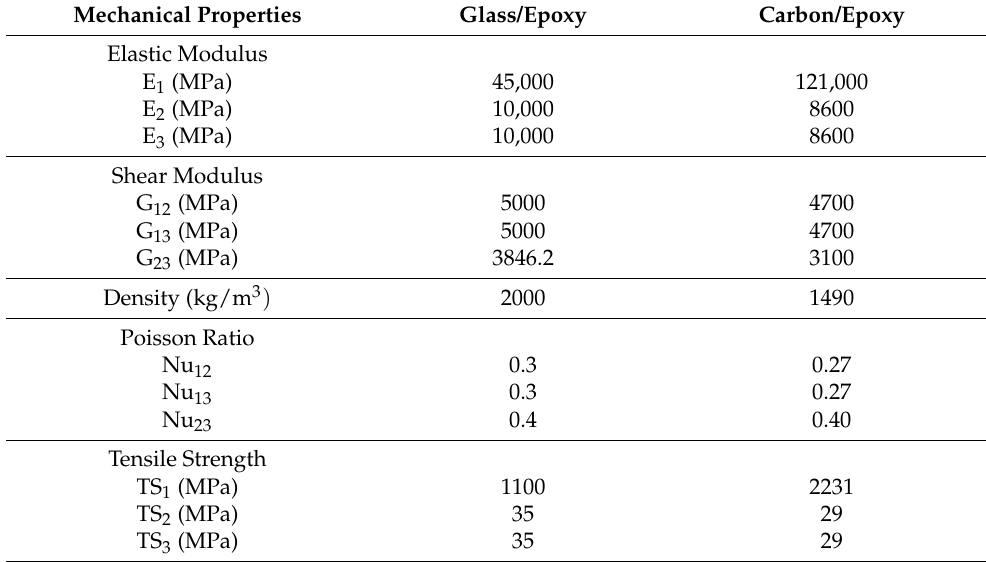
Table 1. Properties of glass/epoxy and carbon/epoxy